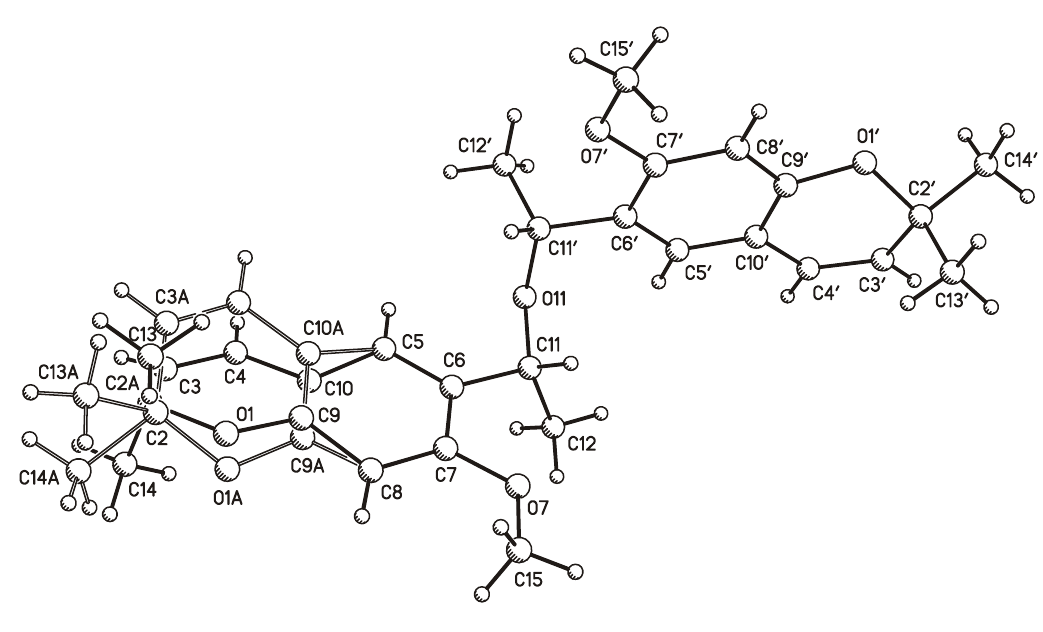
Figure 1. Atom numbering for ( ‒ )-encecanescin ( 1 ). The segments of atoms C1, C2, C3, C4, C9, C10 and the methyl groups at C2 are disordered in the crystal and two conformers ( 1a and 1b labeled with A) are